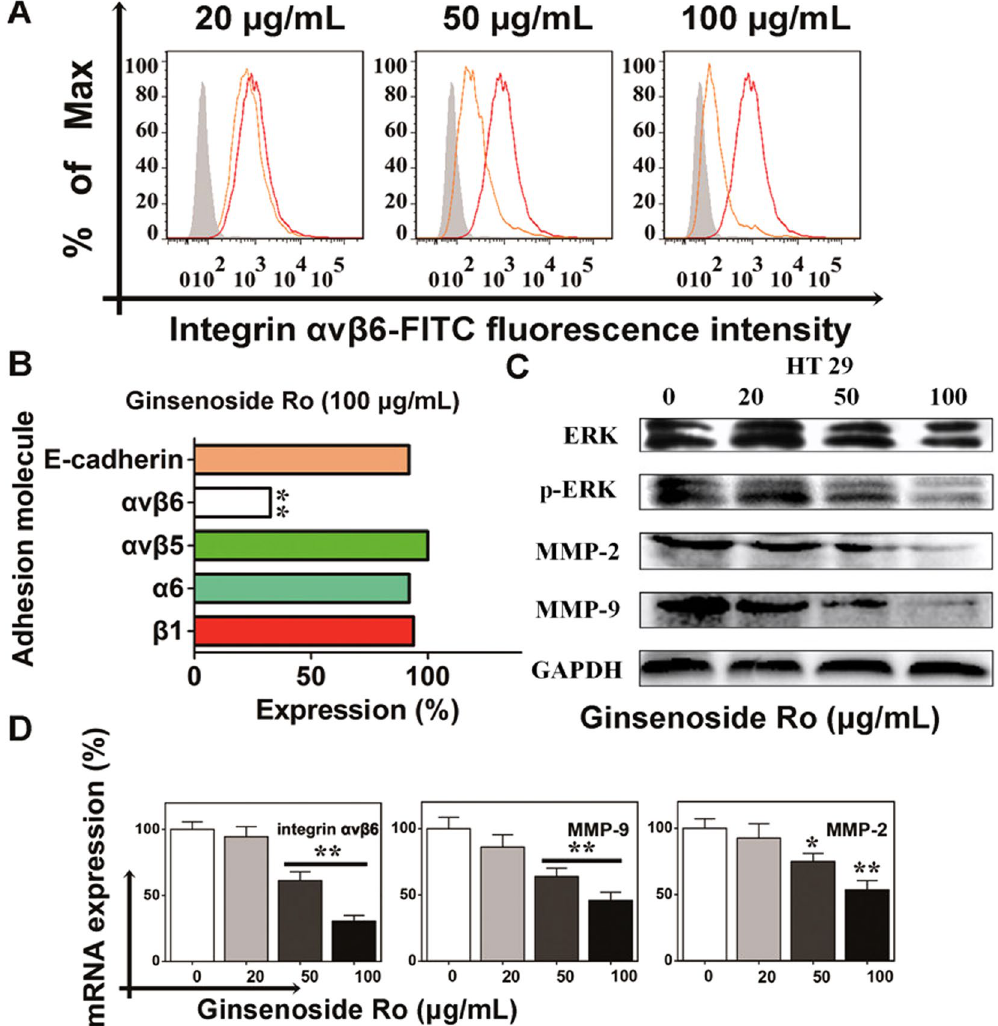
Figure 5. Ginsenoside Ro interfered with integrin α v β 6-associated ERK pathway in HT29. ( A ) Flow cytometric imaging showed expression of integrin α v β 6 on HT29 cells and the inhibition by ginsenoside Ro of the expression. ( B ) Flow cytometric analysis showed that ginsenoside Ro (50 µ g/mL) specifically inhibited integrin α v β 6 expression in HT29 without affecting other integrins and E-cadherin. ( C ) Western blotting stains showed that ginsenoside Ro inhibited expression by HT29 of MMP-2, MMP-9 and ERK phosphorylation in a concentration-dependent manner, and ( D ) the inhibition was further supported by the real-time PCR analysis measuring the transcript levels of integrin α v β 6, MMP-2 and -9 in HT29 cells. Each bar represents the mean ± SD, (n = 3–5). * P < 0.05, and ** P < 0.01, compared with the